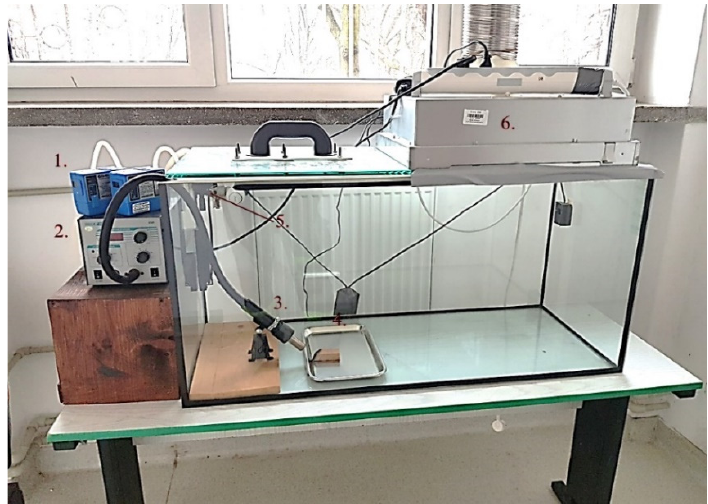
Figure 1. Measuring stand: 1—GilAir-3 personal aspirators; 2—device regulating heat release; 3—source of radiation; 4—tray with tested combustible material; 5—heads for collecting respirable and total suspended particle (TSP) fractions; 6—exhaust smoke.